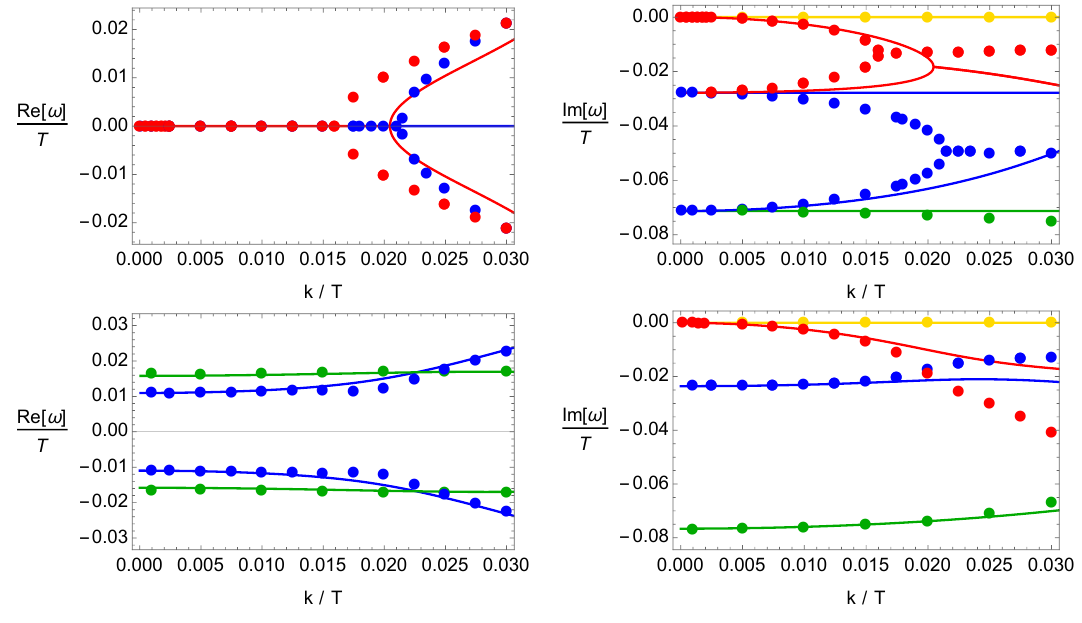
Figure 3 . Dispersion relations of the lowest QNMs at finite density ( µ/T = 0 . 5 ). Top and bottom panels refer respectively to B/T 2 = 0 , 0 . 5 .